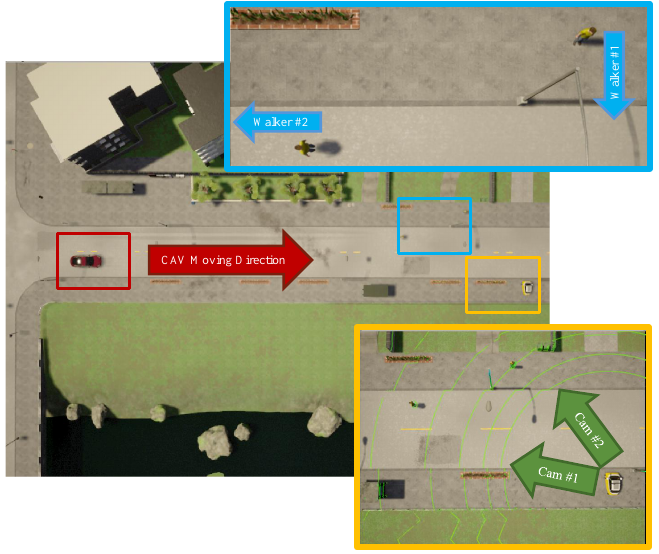
Figure 16. Experiment setup in the CARLA simulator. The CAV, a red car, moved to the east direction towards two walking pedestrians and an IRSU deployed on the roadside. The IRSU was spawn in CARLA as a mini car parked on the